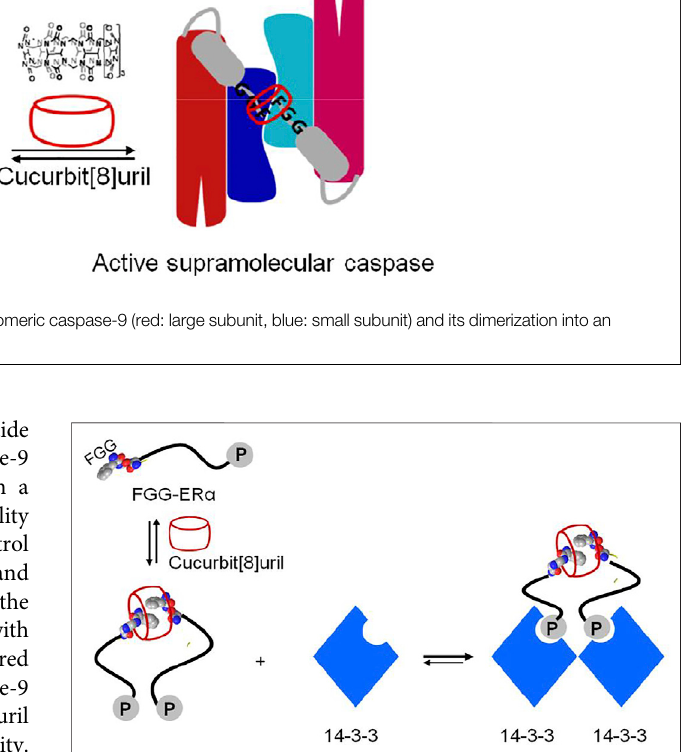
FIGURE 9 | Schematic representation of cucurbit[8]uril-induced protein assemblies of phosphopeptide (FGG-ER α ) and protein